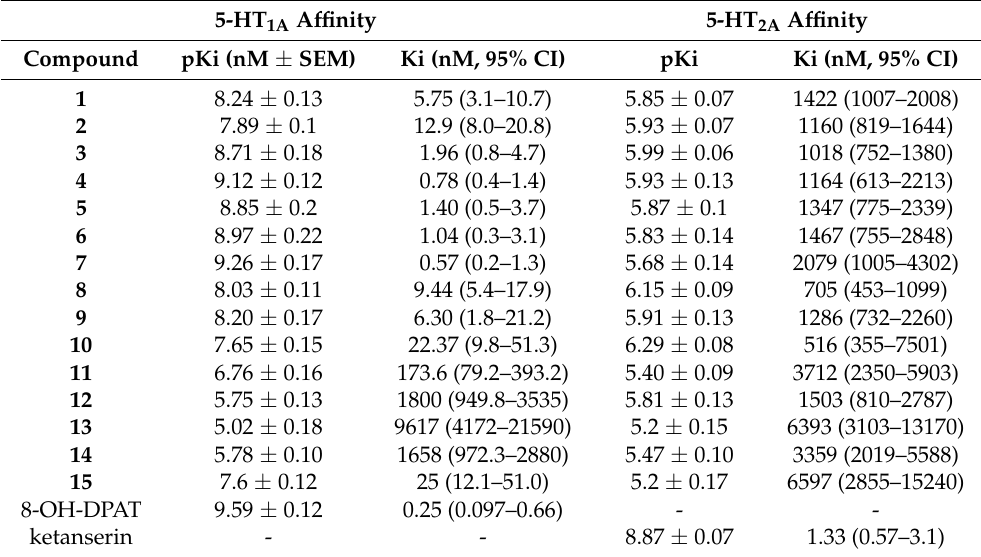
Table 4. Affinities of compounds 1 – 15 for 5-HT 1A and 5-HT 2A